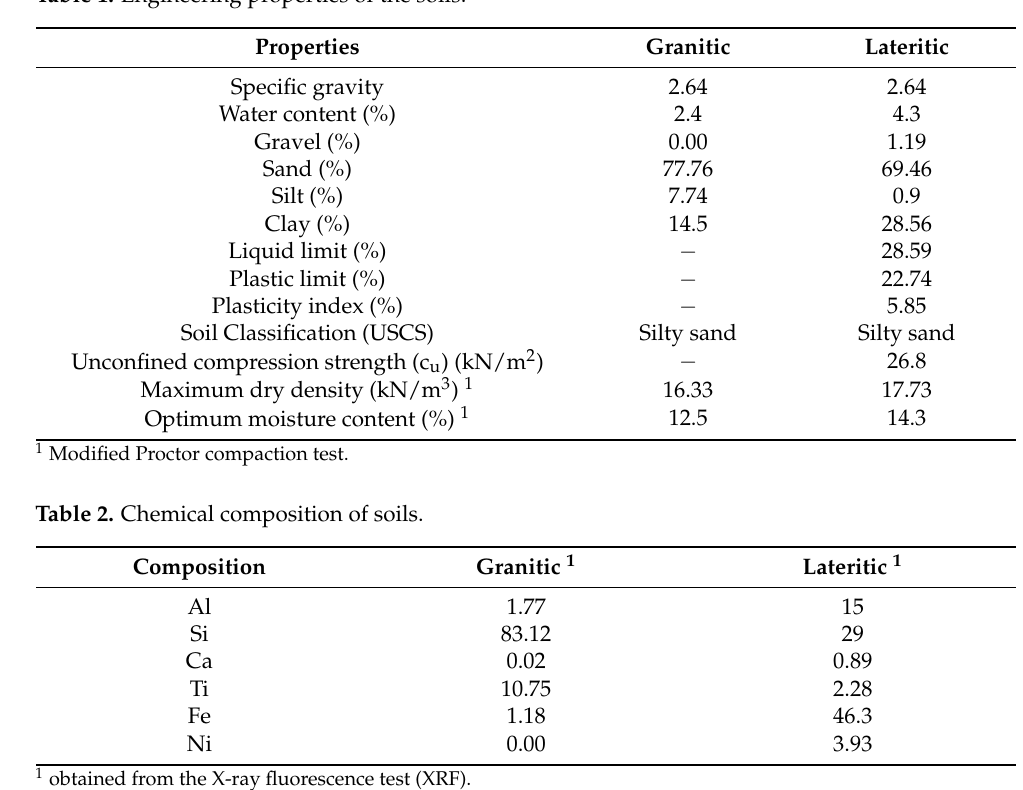
Figure 2. ( a ) Granitic soil, and ( b ) Granitic soil deposits in Hampalit village, Central Kalimantan. Table 1. Engineering properties of the soils.